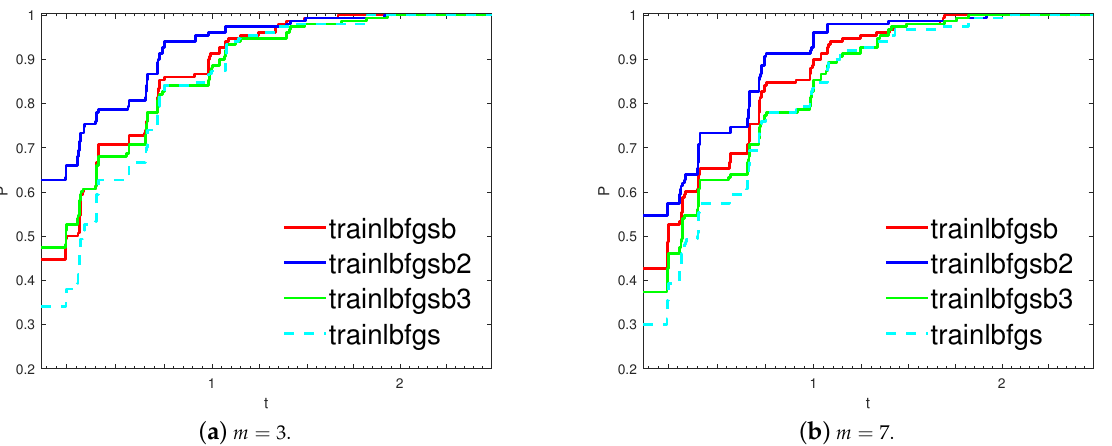
Figure 8. Log 10 scaled performance profiles based on F 1 -score for the Escherichia coli classification